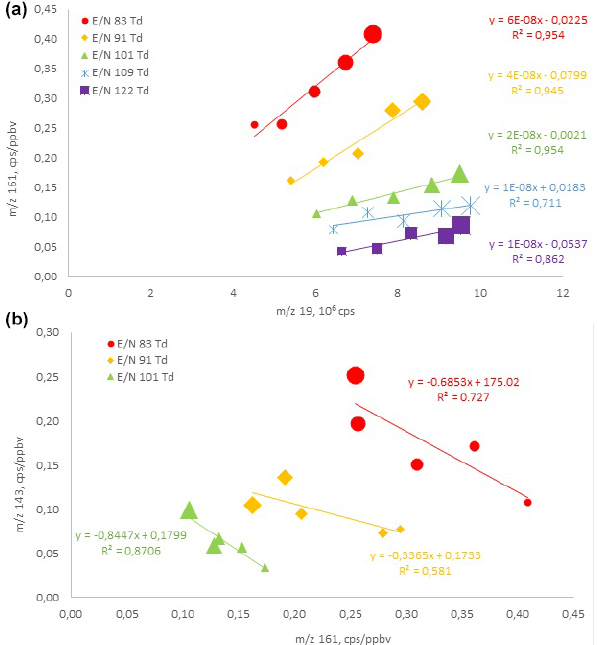
Figure 4. Intensities of the n -decane-water cluster ( m/z 161, M · H 3 O + ) vs. (a) hydronium ( m/z 19, H 3 O + ) and (b) proton transfer product ( m/z 143, M + H + ) . Marker size illustrates the U SO : smallest is 60V and largest is180V. No correlations were ob- served at 109 and